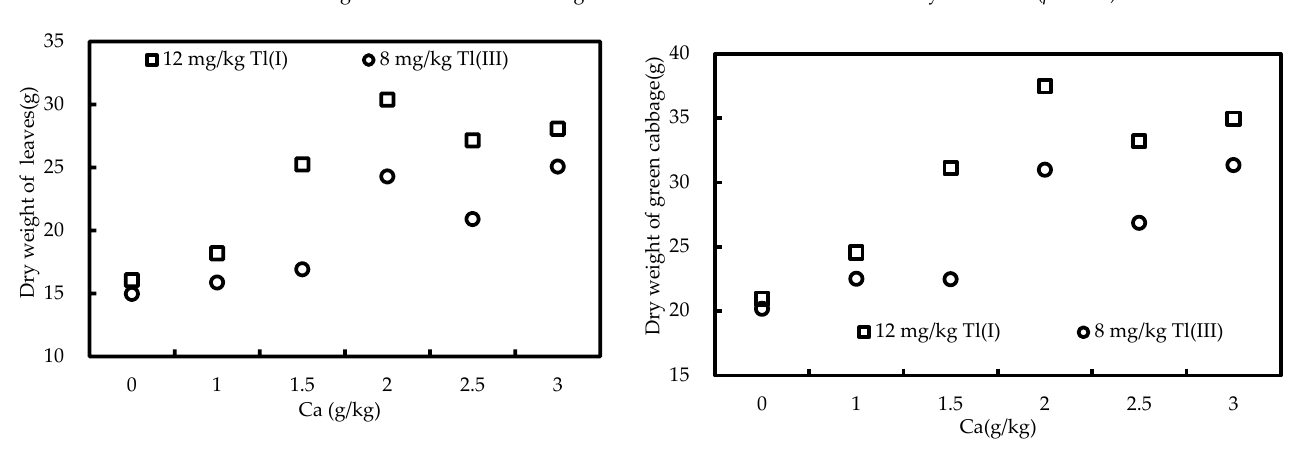
Significant differences among different Ca treatments are indicated by lowercase ( p < 0.05).